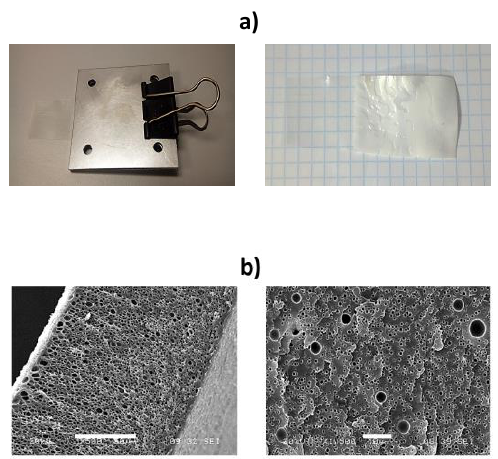
Figure 1. ( a ) Experimental setup to obtain a film with solid and foamed regions: Steel mold ( left ) and film after ScCO 2 processing with the two regions ( right ); ( b ) SEM micrographs of the foamed region of the sensory film: Cross-section ( left , bar scale 50 µm) and surface ( right , bar scale 10 µm).